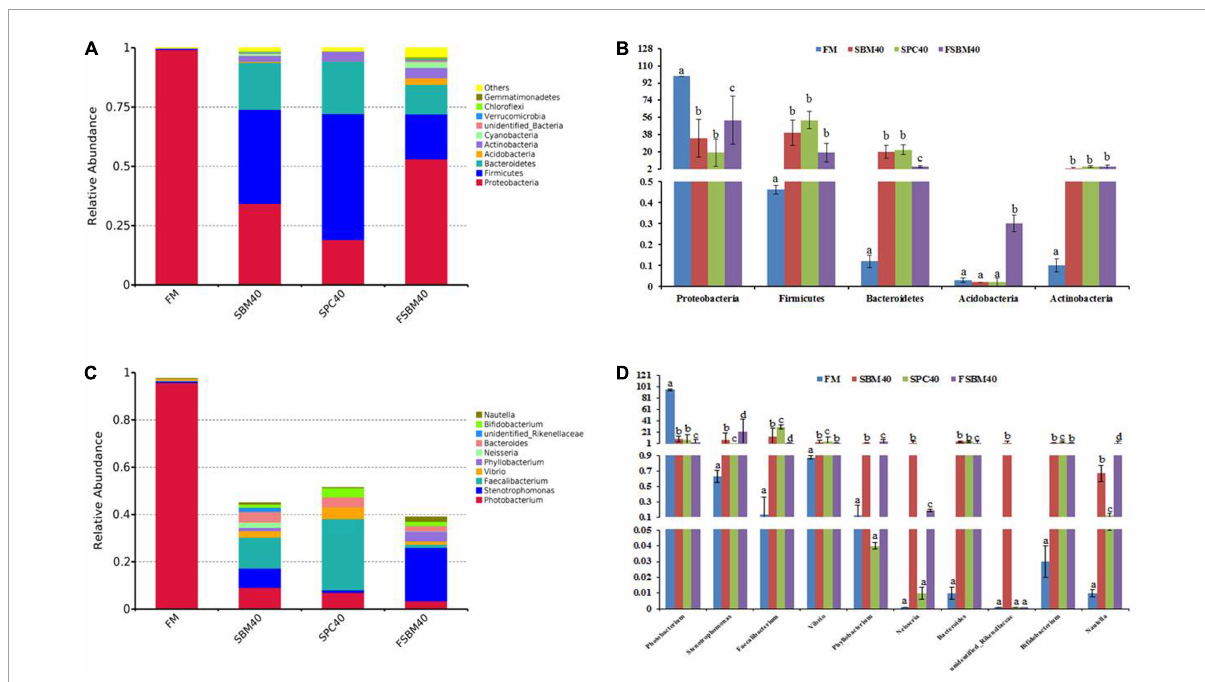
FIGURE3 The gut flora composition and abundance of different soy meals substitution for fish meal in pearl gentian grouper [ (A,B) phylum level and (C,D) genus level]. (A) Rarefaction curve; (B) rank abundance; (C) species accumulation boxplot. Different letters distributed on the column represented significant variances between the groups at P < 0.05 ( n =